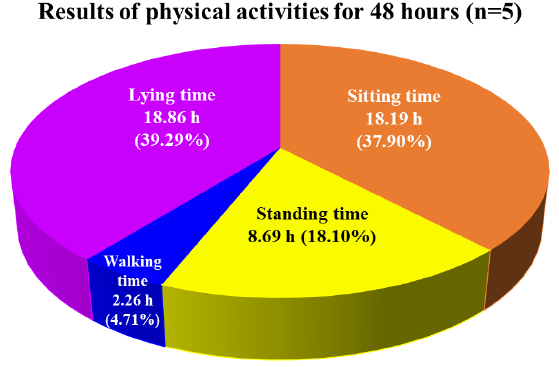
Figure 7. Average of daily physical activities for older adults with clinically confirmed cognitive impairment ( n = 5), including the average cumulative postures as durations of sitting, standing, walking, and lying time for 48 h by monitoring pendant sensor (PAMSys+).